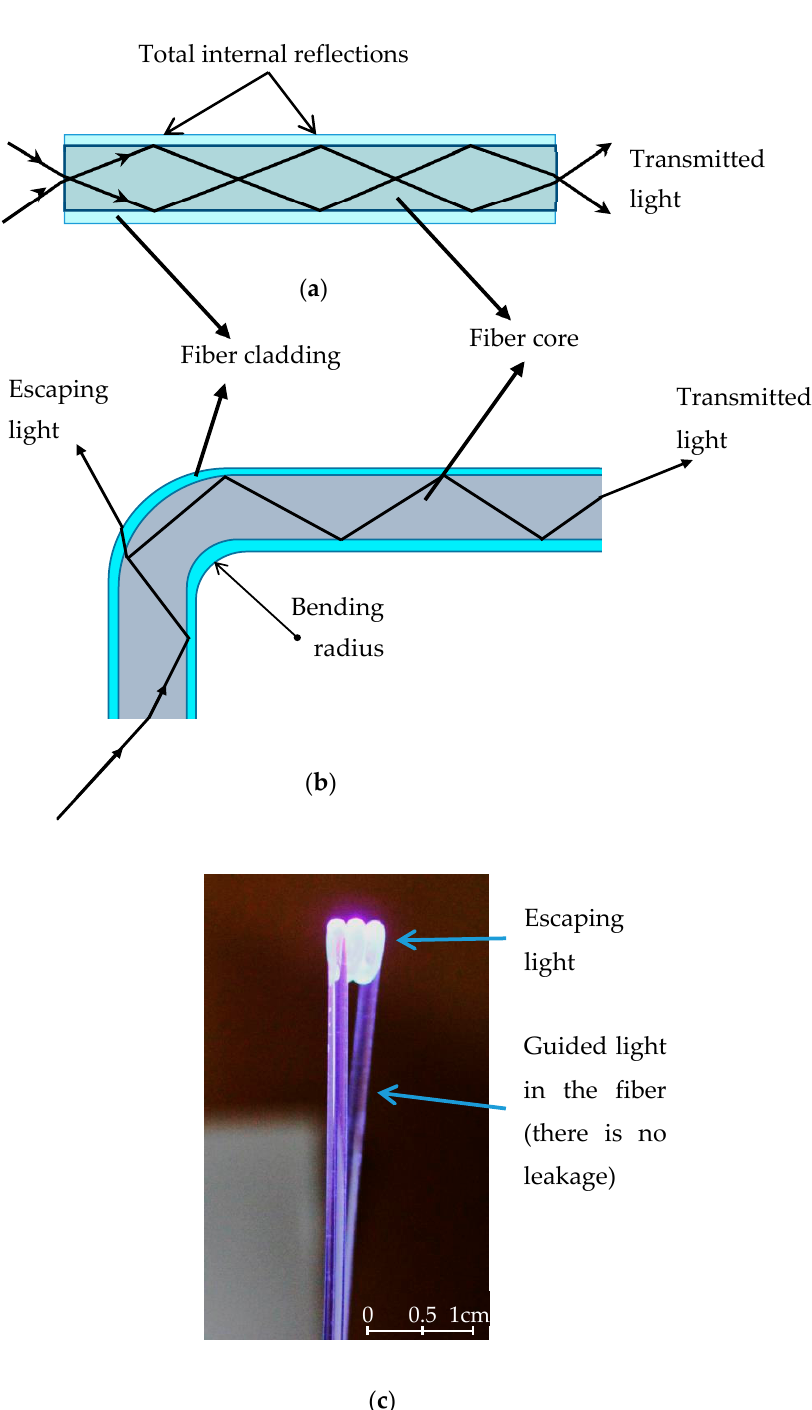
Figure 1. Light guiding in a multimode fiber. ( a ) Total internal reflection; ( b , c ) escaping light because of the bending.